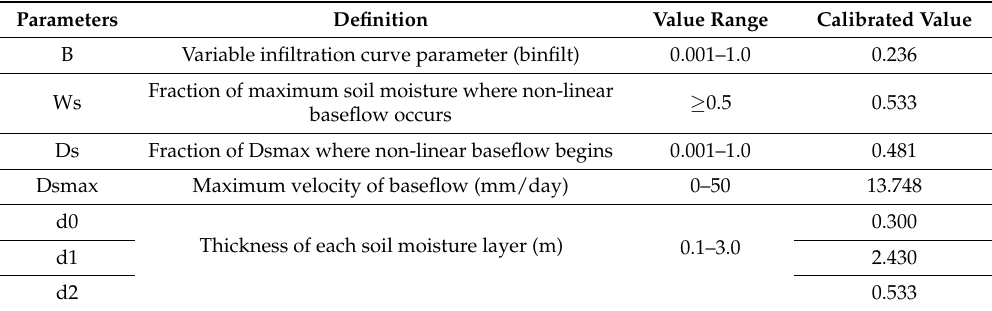
Table 5. The VIC model Calibrated Parameters and Calibrated Values in Ganjiang River Basin.